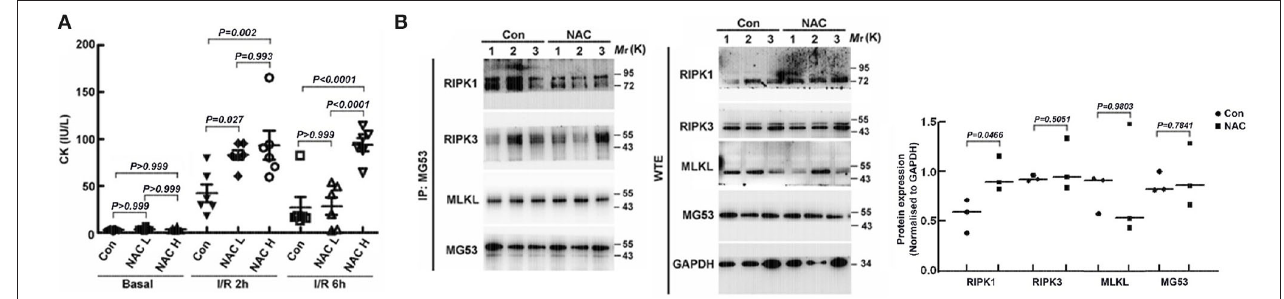
FIGURE 1 | ROS plays a role in regulating the interaction between MG53 and RIPK1 in the injured myocardium. (A) The cardiac protective action of rhMG53 was determined by CK lease assay. The beneficial effects of rhMG53 treatment were blunted by treatments of low dose (50 mg/kg, NAC L) and high dose (250 mg/kg, NAC H) of NAC ( n = 6 per group for control, NAC low dose and NAC high dose). The animals in all experimental groups were treated with rhMG53. (B) NAC (50 mg/kg) was injected (IP) into mice before ischemia and reperfusion. Interaction between MG53 and RIPK1 in injured myocardium was determined